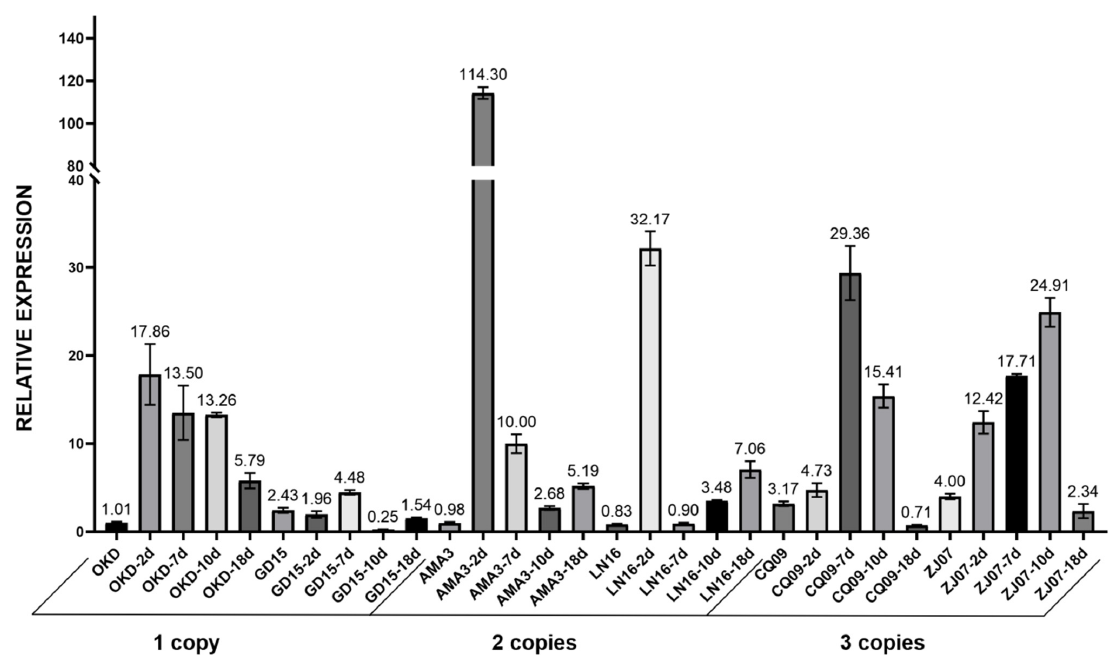
Figure 3. Relative expression of 6 B. xylophilus strains with different copy numbers after inoculat- ing on pine trees for 2 days, 7 days, 10 days and 18 days. on pine trees for 2 days, 7 days, 10 days and 18